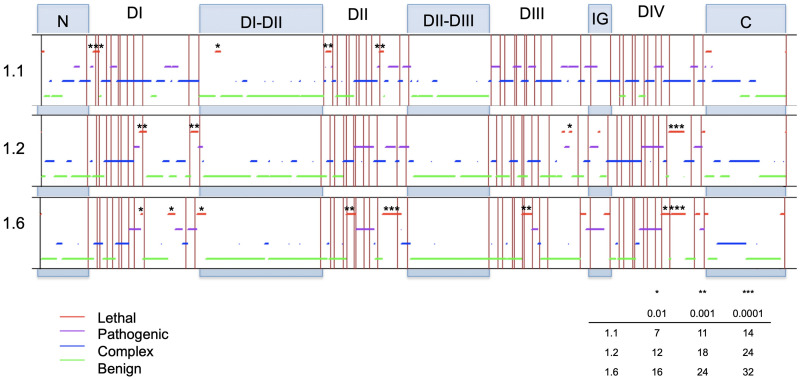
Cumulative distribution functions for NaV1.1, 1.2, and 1.6 missense mutations.Comparison of public mutations (black line) and patient missense mutations (red line). The vertical lines represent the segment and domain boundaries for each channel. The table shows the thresholds for lack of variants to obtain the given p-values for the lethality test.